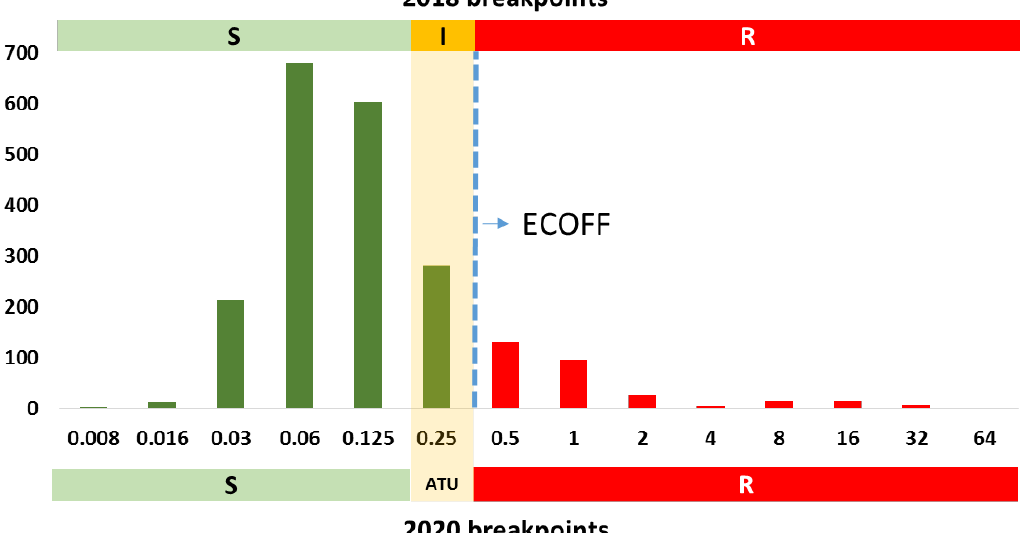
Figure 4. MIC distribution for posaconazole against A. fumigatus complex. Columns depicted in green represent phenotypically posaconazole wild-type isolates; columns depicted in red represent phenotypically posaconazole non-wild-type isolates. Horizontal bars indicate clinical breakpoints for the S (green) and R (red) categories, as well as the former “I” (orange) category; new (2020) and former (2018) breakpoints are shown. The new area of technical uncertainty (ATU) is represented by a light orange shaded column (0.25 mg / L). Data extracted from the posaconazole vs. Aspergillus rational document v2.0 (https: // www.eucast.org / asto ff ungi / rationale_documents_for_antifungals / accessed